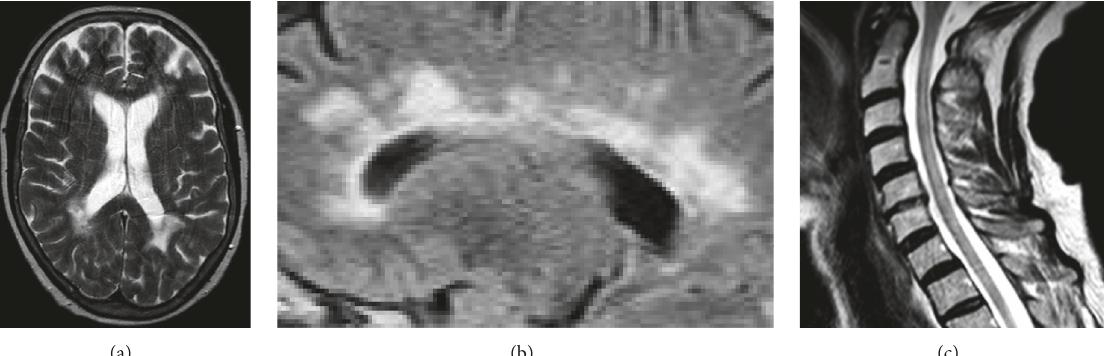
Figure 1: Brain and spinal MRI of the patient following admission on 12 October 2014. (a) Brain T2W axial MRI (1.5 T) demonstrating the characteristic periventricular lesions of MS. (b) Magnification of brain FLAIR sagittal MRI showing involvement of the corpus callosum. (c) Sagittal T2W spinal MRI of the cervical cord with diffuse, patchy lesions. T2W: T-2 weighted; FLAIR: Fluid-Attenuated Inversion Recovery; T: